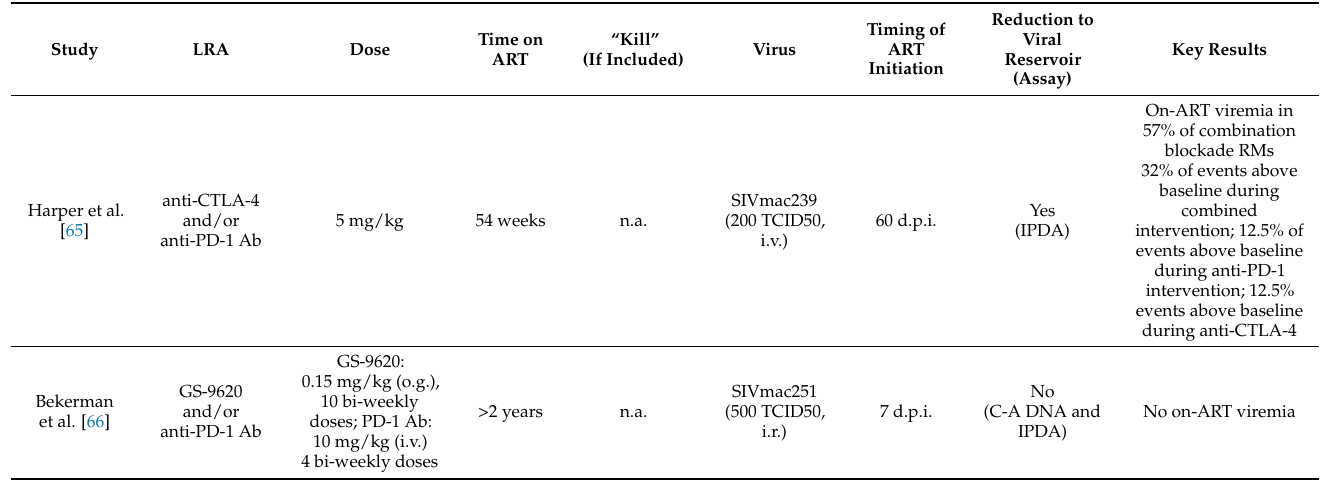
Table 3. Recent NHP studies testing immune checkpoint inhibitors as an LRA. Ab, antibody; TCID50, 50% tissue culture infectious dose; i.v., intravenous; i.r., intrarectal; o.g., oral gastric; d.p.i., days post-infection; RM, rhesus macaque; C-A, cell-associated; IPDA, intact proviral DNA